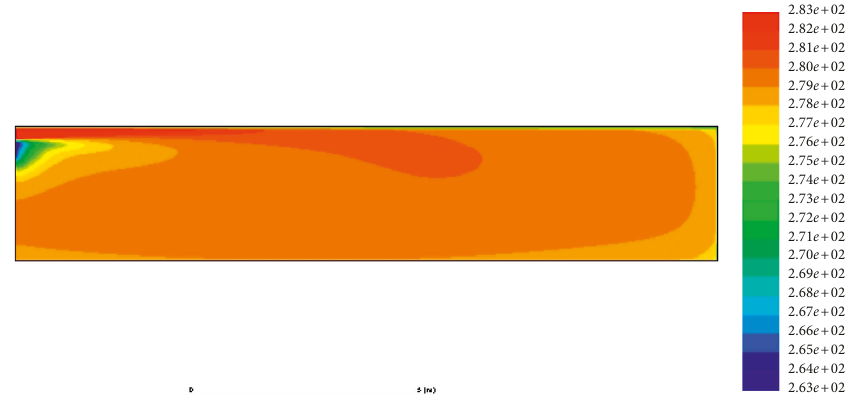
Figure 10: Temperature in the roadway during forced ventilation.